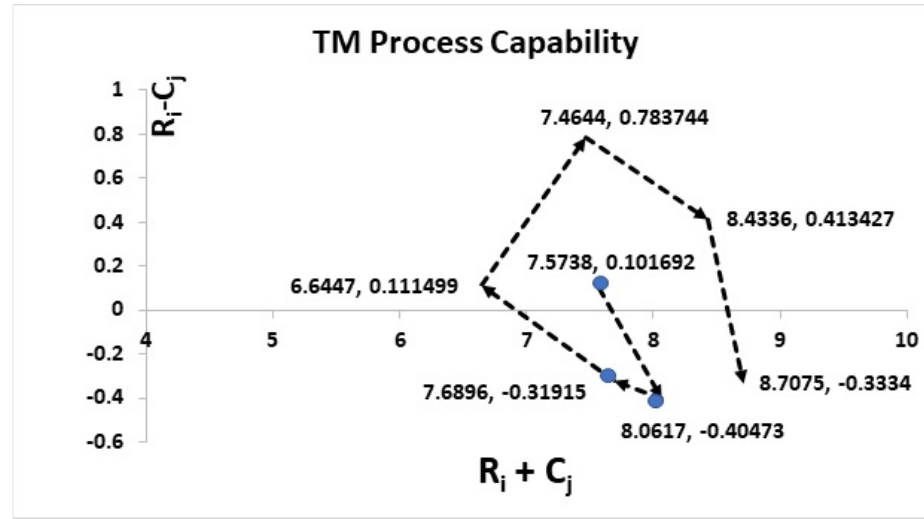
Figure 9. The IRM for the TM process capability (T Criteria ).